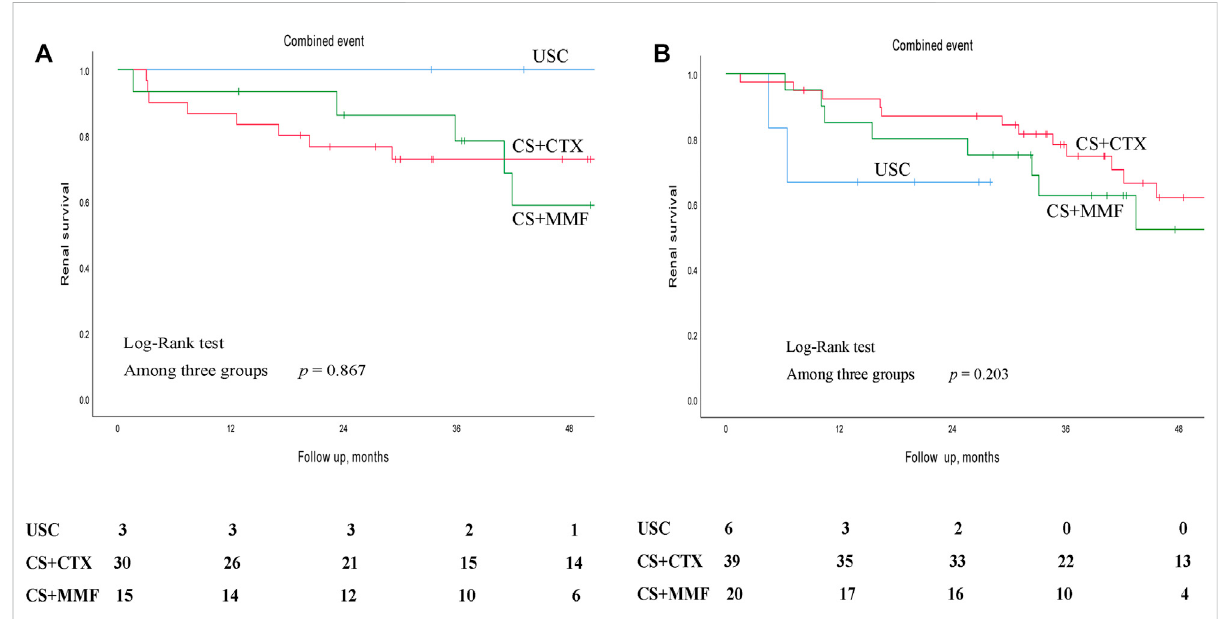
FIGURE 3 Kaplan-Meier survival curves for free of combined event of different subgroups in patients with uncontrolled supportive care (USC), corticosteroids (CS) combined with cyclophosphamide (CTX), and CS combined with mycophenolate mofetil (MMF). (A) In the subgroup of IgAN patients with E1 plus C1-C2 (regardless M, S, T). (B) In the subgroup of IgAN patients with S1 plus T1-T2 (with negative E and negative C).